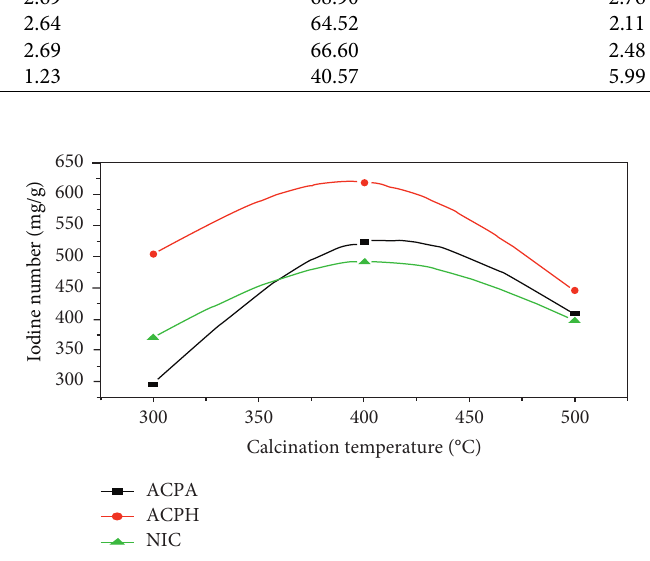
Figure 3: Effect of calcination temperature on the iodine number. Table 3: Surface functional groups of precursors and activated carbon from peelings of cassava